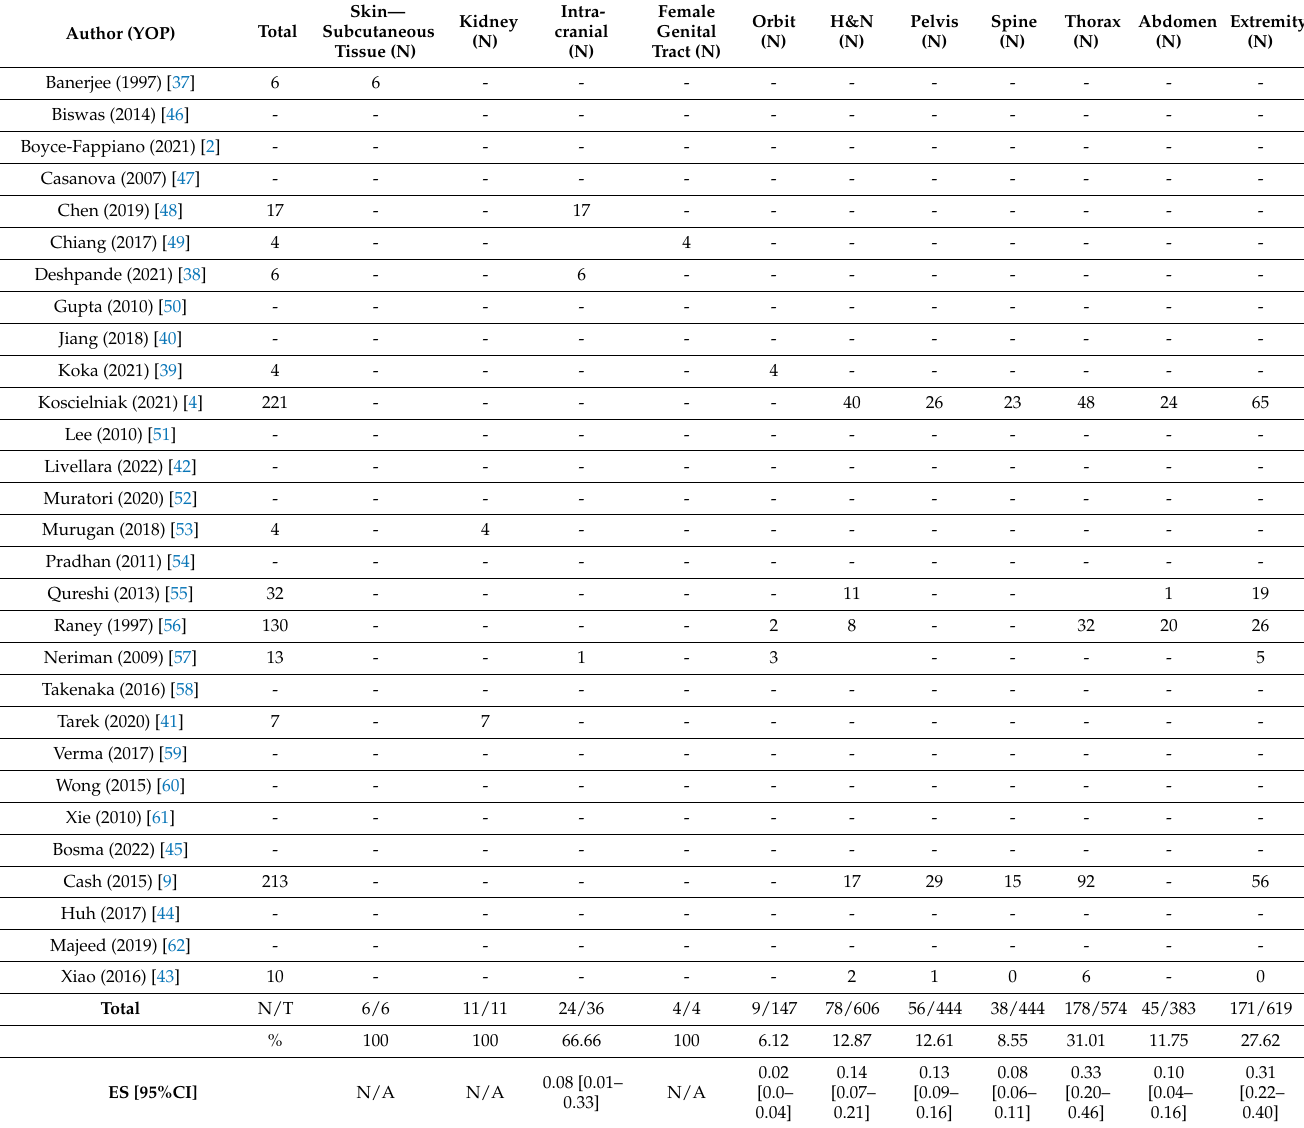
Table 3. The location of extraosseous Ewing sarcoma in the pediatric